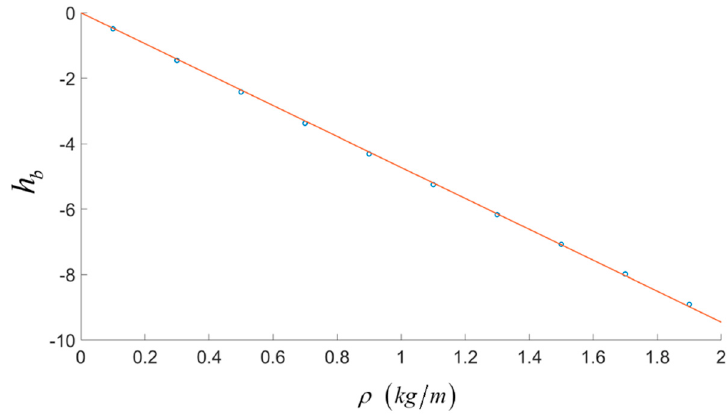
Figure 7. The relationship between β and h b with given ς